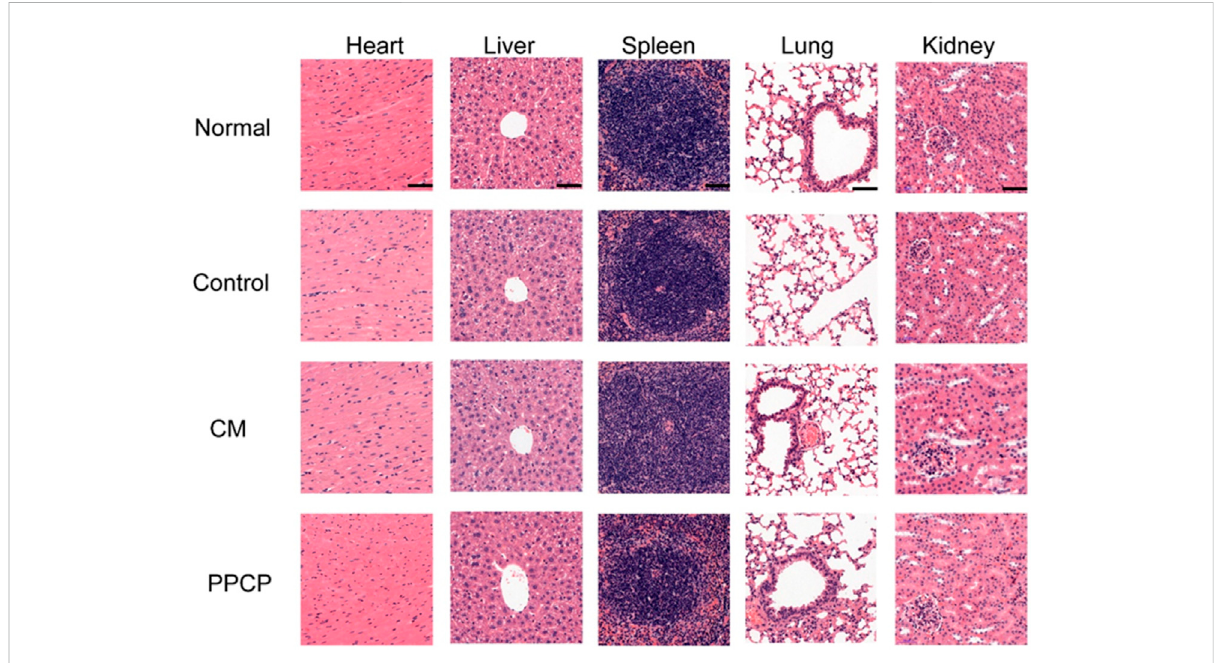
FIGURE 7 The H&E staining of the heart, liver, spleen, lungs, and kidneys on day 21 (scale bar represents 50 μ